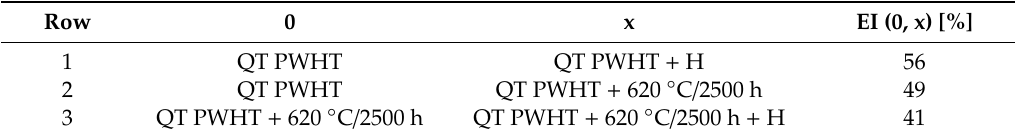
Table 3. Index of embrittlement for individual material states.